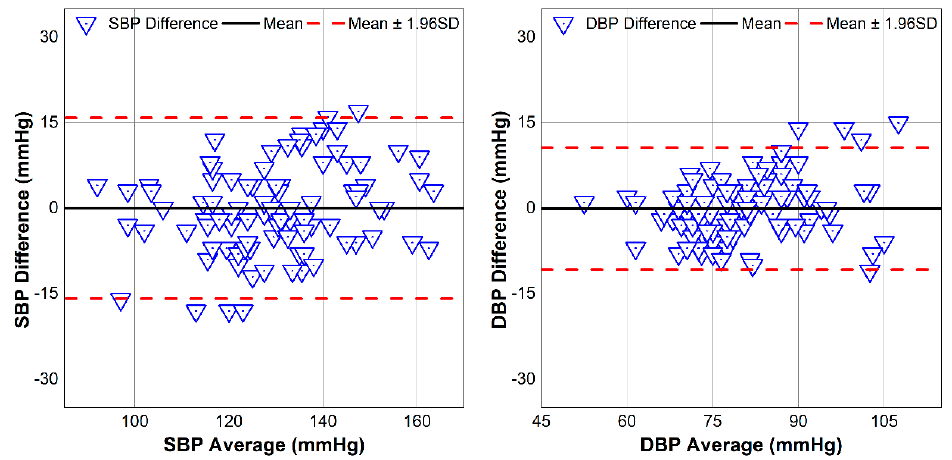
Figure 14. Bland–Altman plots for all subjects between estimated BP and reference BP.